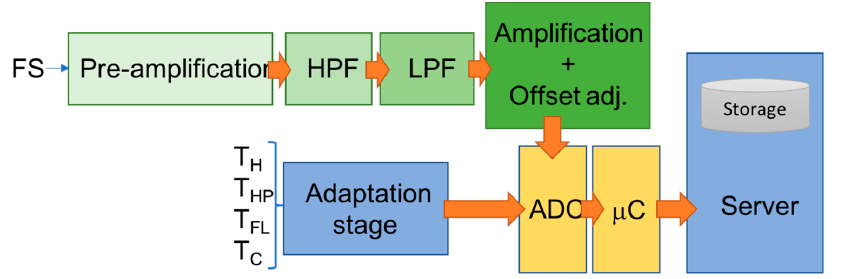
Figure 6. Outline of the electronic system responsible for aHB sensor adaptation and data signal acquisition.